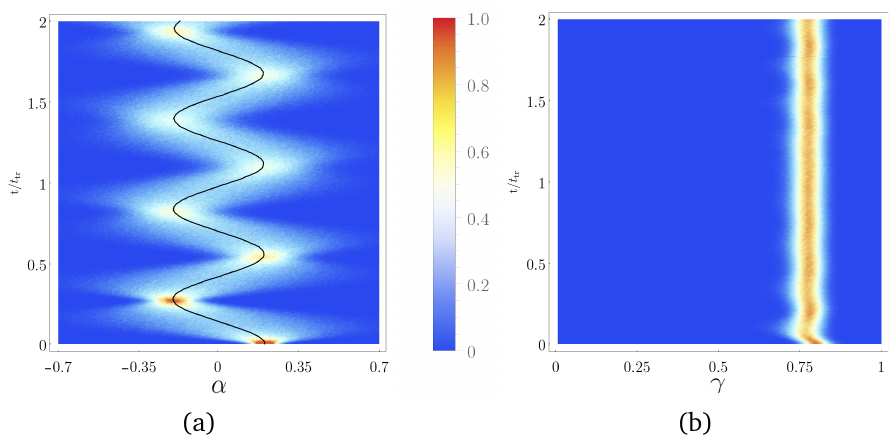
( α , t , t ) (a) and P ( γ , t , t ) for the observables C (cid:96) 1 1 (cid:96) = 15ms and integration